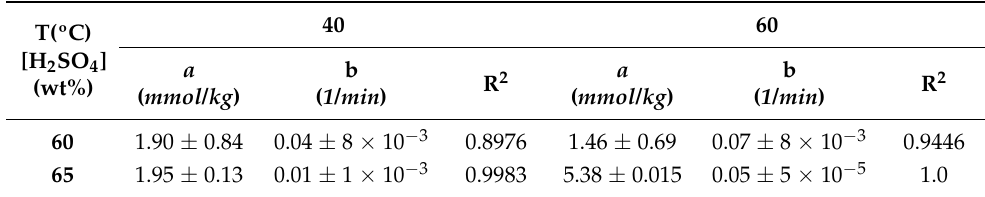
Table 3. Total sulfate groups content equation parameters.